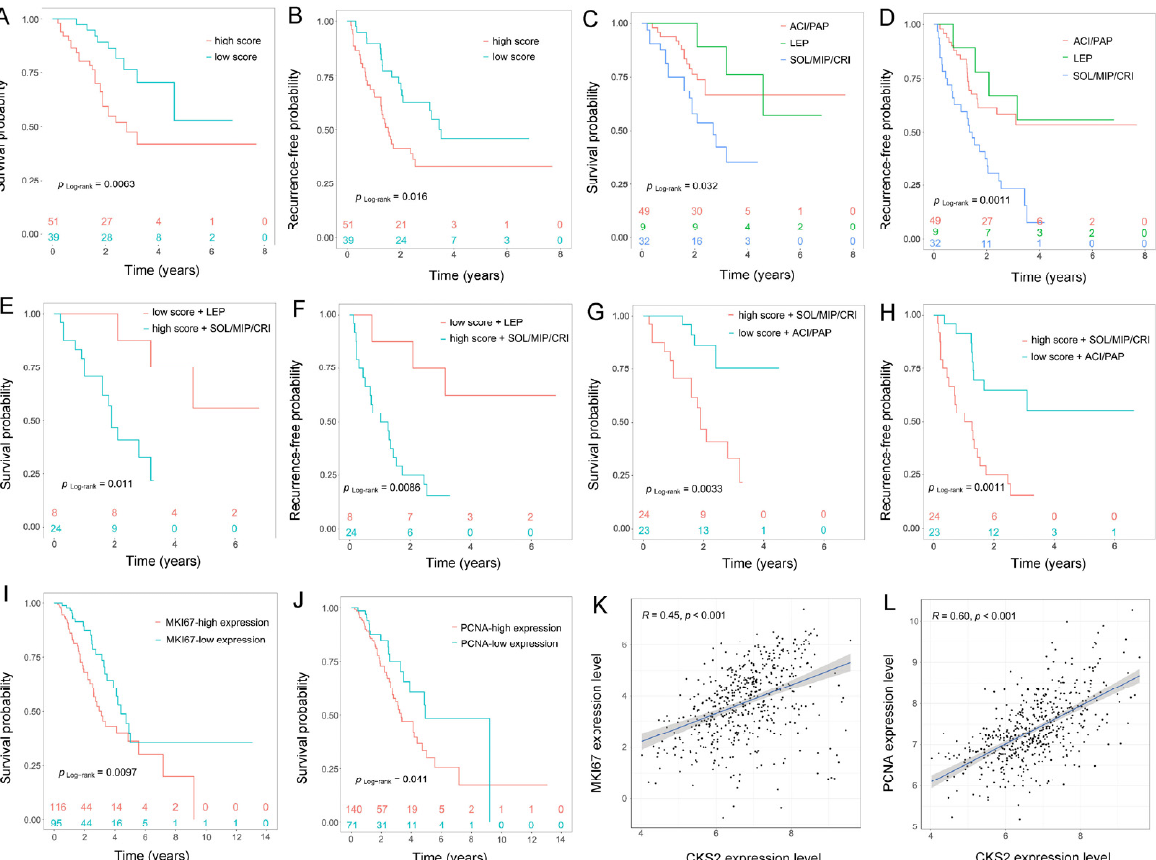
Figure 2. Prognostic significance of CKS2. ( A , B ) The difference in OS and RFP between CKS2-low and CKS2-high expression groups. ( C , D ) The difference in OS and RFP between various histological subtype clusters. ( E – H ) Prognosis analysis of CKS2 combined with different histological subtype clusters. ( I , J ) K-M survival analysis of MKI67 and PCNA based on TCGA database. ( K , L ) Correlation between CKS2 and MKI67 and PCNA based on TCGA database. OS, overall survival, RFP, recurrence-free progression.